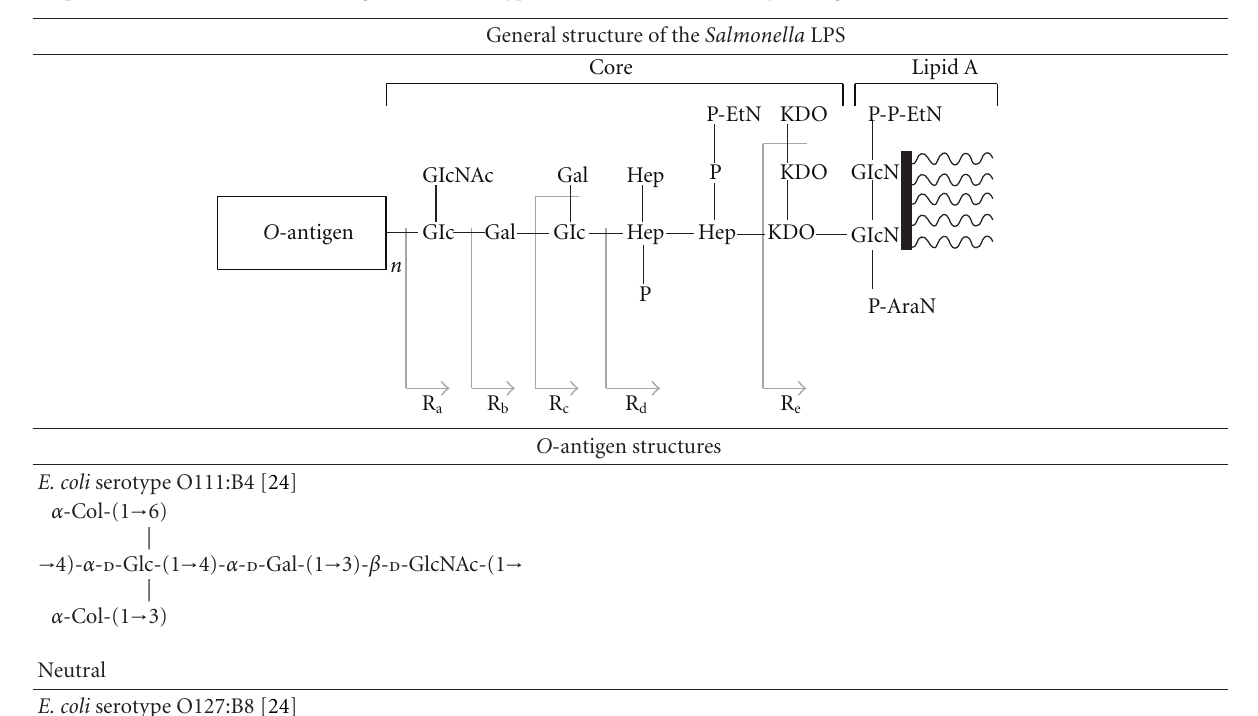
Table 1: The structures of the core oligosaccharide and O -antigen polysaccharides of the LPS samples used in this study. The general structure of the Salmonella LPS is shown in the first row. The stages at which the biosynthetic enzyme defects disrupt biosynthesis resulting in the production of the truncated “rough” LPS chemotypes R a → R e are indicated by the segmented